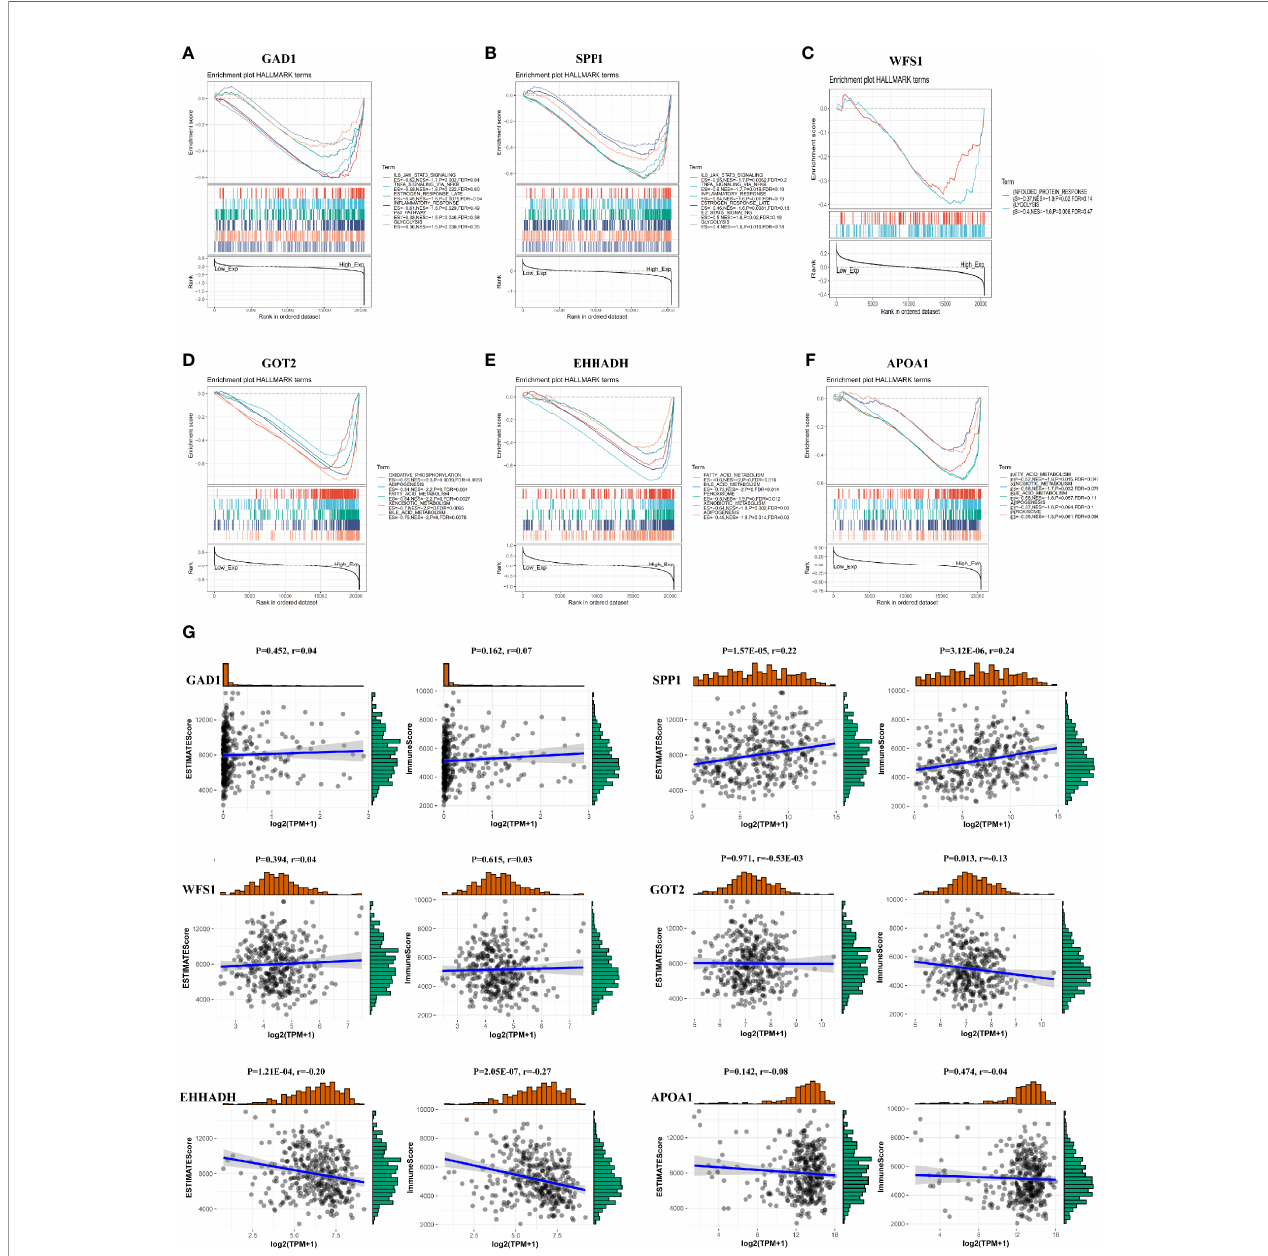
FIGURE 9 | GSEA and immune/stromal/Estimate score for six MRGs in HCC. (A – F) Top six gene sets according to GSEA enrichment scores for GAD1, SPP1, WFS1, GOT2, EHHADH, and APOA1. (G) Association between immune/stromal/Estimate score and six MRGs after ESTIMATE algorithm